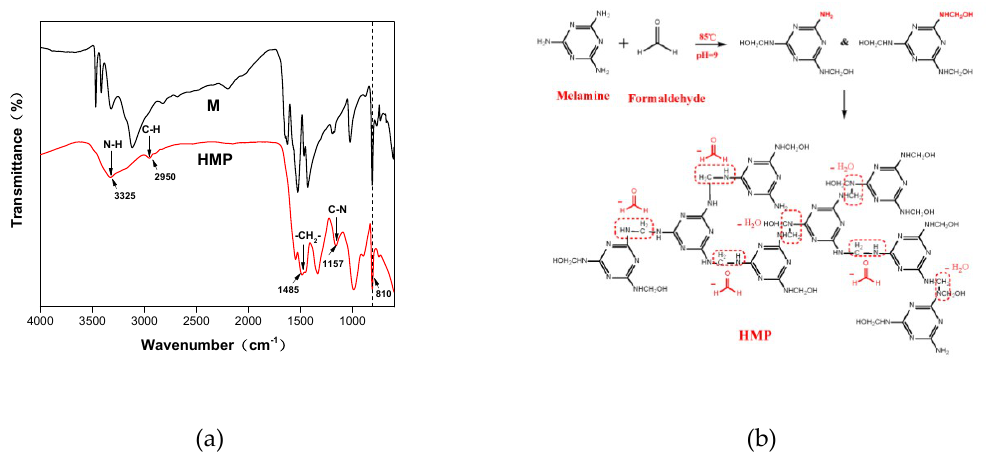
Figure 1. FTIR spectra of HMP ( a ) and the reaction schematic of HMP ( b ).